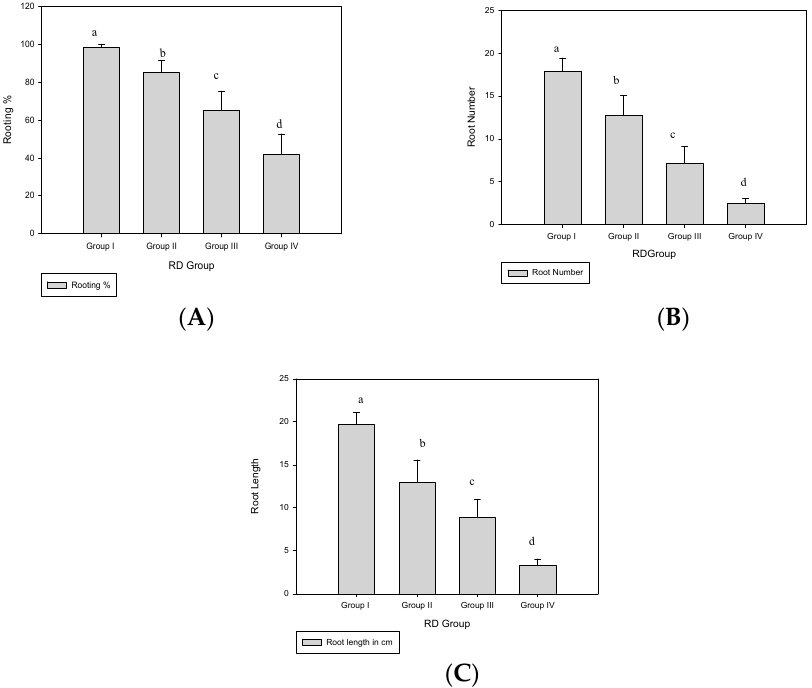
Figure 2. Effect of root diameter on rooting ( A ), root number ( B ), and root length ( C ) of Ficus elastica Roxb. Means within a treatment followed by different letters significantly differ at p < 0.05 by the least significant difference (LSD) test.